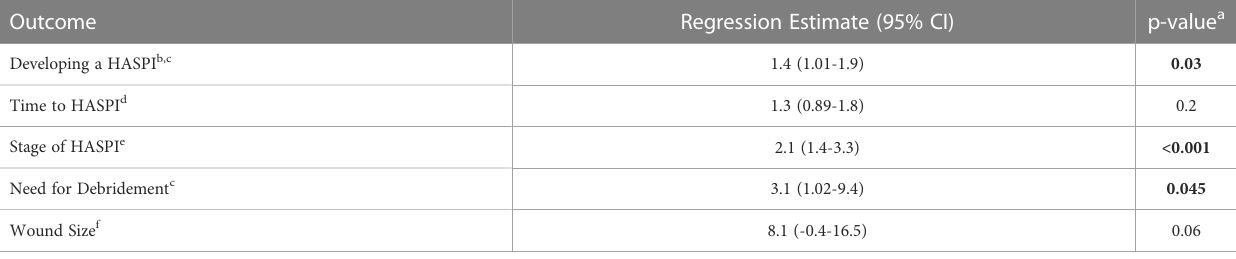
TABLE 2 Multivariable logistic regression model assessing the impact of COVID-19 status (positive vs . negative) on HASPI development and characteristics. Outcome Developing a HASPI